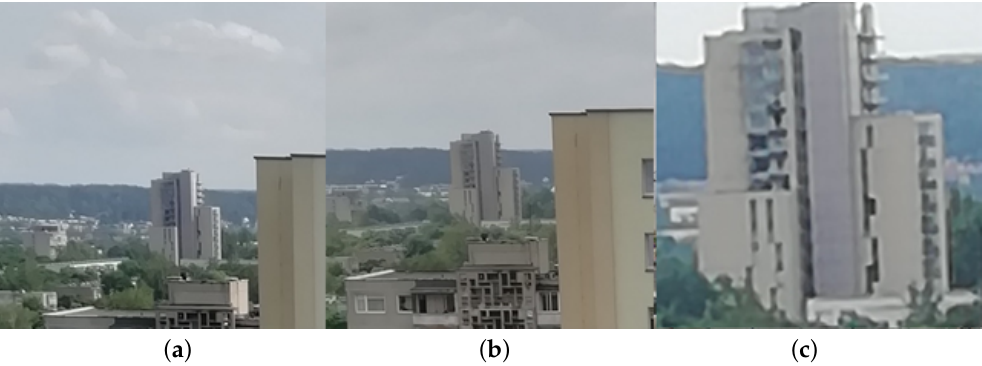
Figure 1. Examples of building images: ( a ) image from a natural distance; ( b ) a view with a slight “floating effect” due to direct sunlight; ( c ) a captured image with a specific departure of